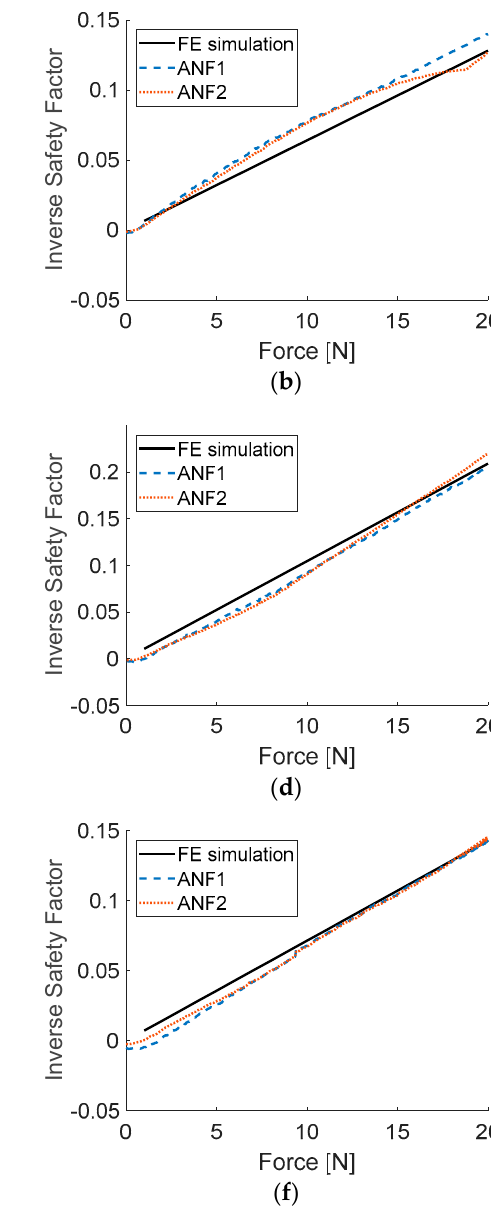
Figure 8. Results of testing ANFIS models: ( a ) load case LC1, numerical input data; ( b ) load case LC1, experimental input data; ( c ) load case LC2, numerical input data; ( d ) load case LC2, experimental input data; ( e ) load case LC3, numerical input data; ( f ) load case LC3, experimental input data.